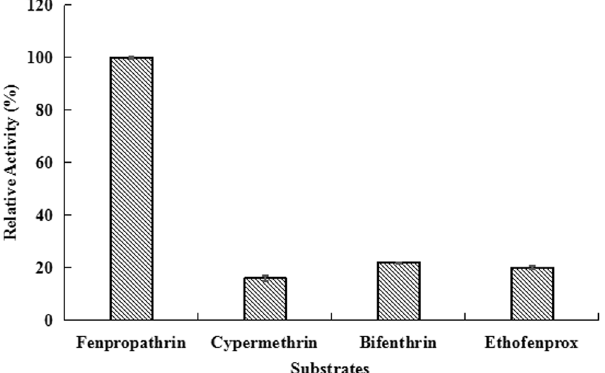
Figure 3. Substrate specificity analysis for purified Est3385 protein. The substrate activity was set as 100% for reactions with fenpropathrin as the substrate. Each result is the mean of three independent experiments ± standard deviation.